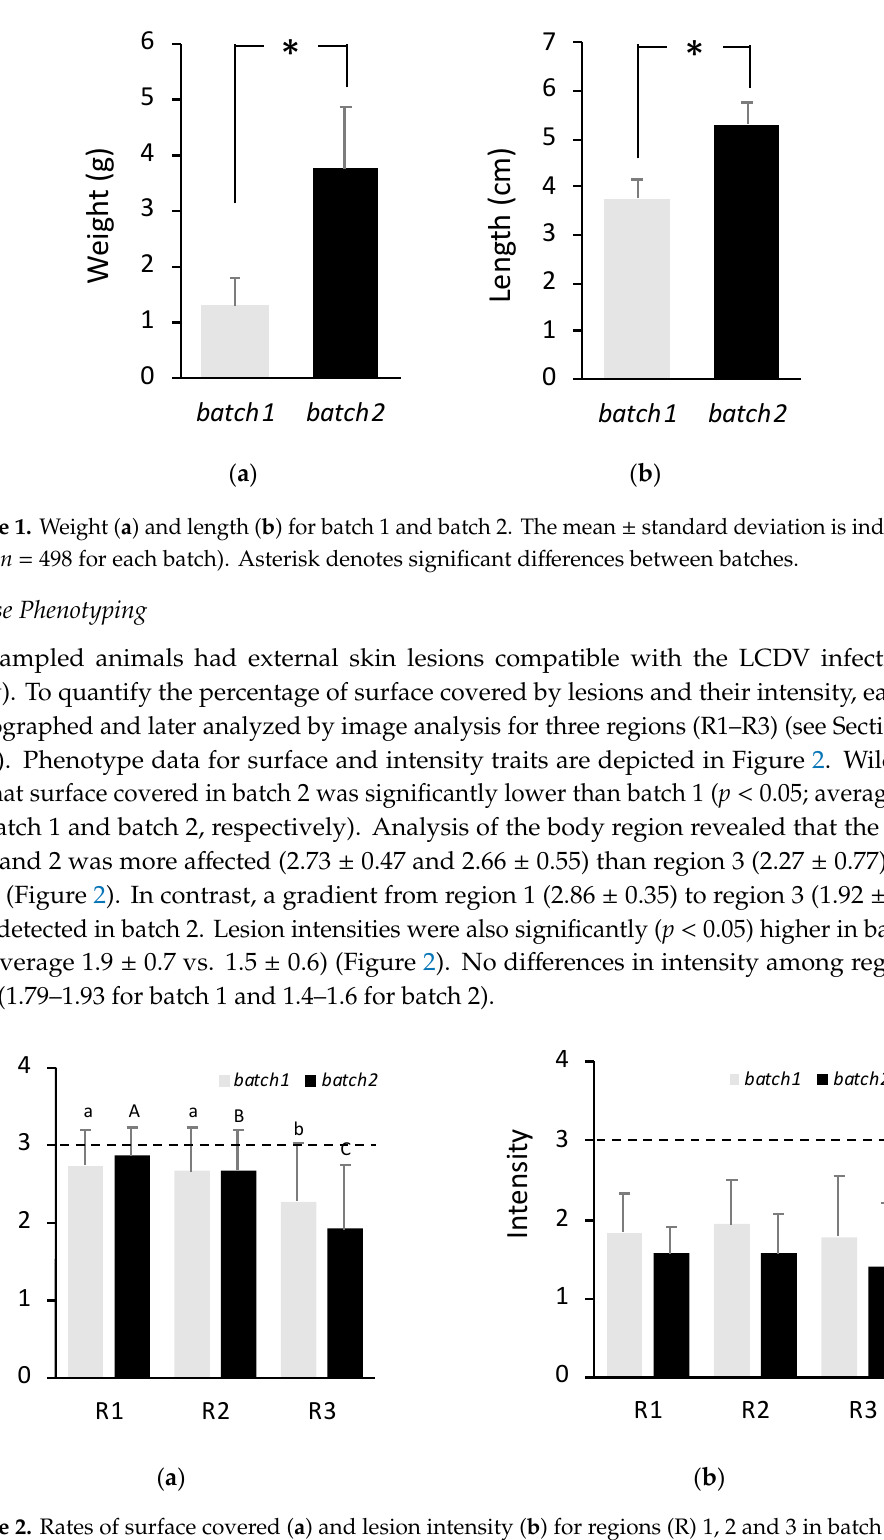
Figure 2. Rates of surface covered ( a ) and lesion intensity ( b ) for regions (R) 1, 2 and 3 in batch 1 and batch 2. The dashed line indicates the maximum rate value. Letters indicate significant differences between regions for batch 1 (lowercase) or batch 2 (uppercase). Mean ± standard deviation is